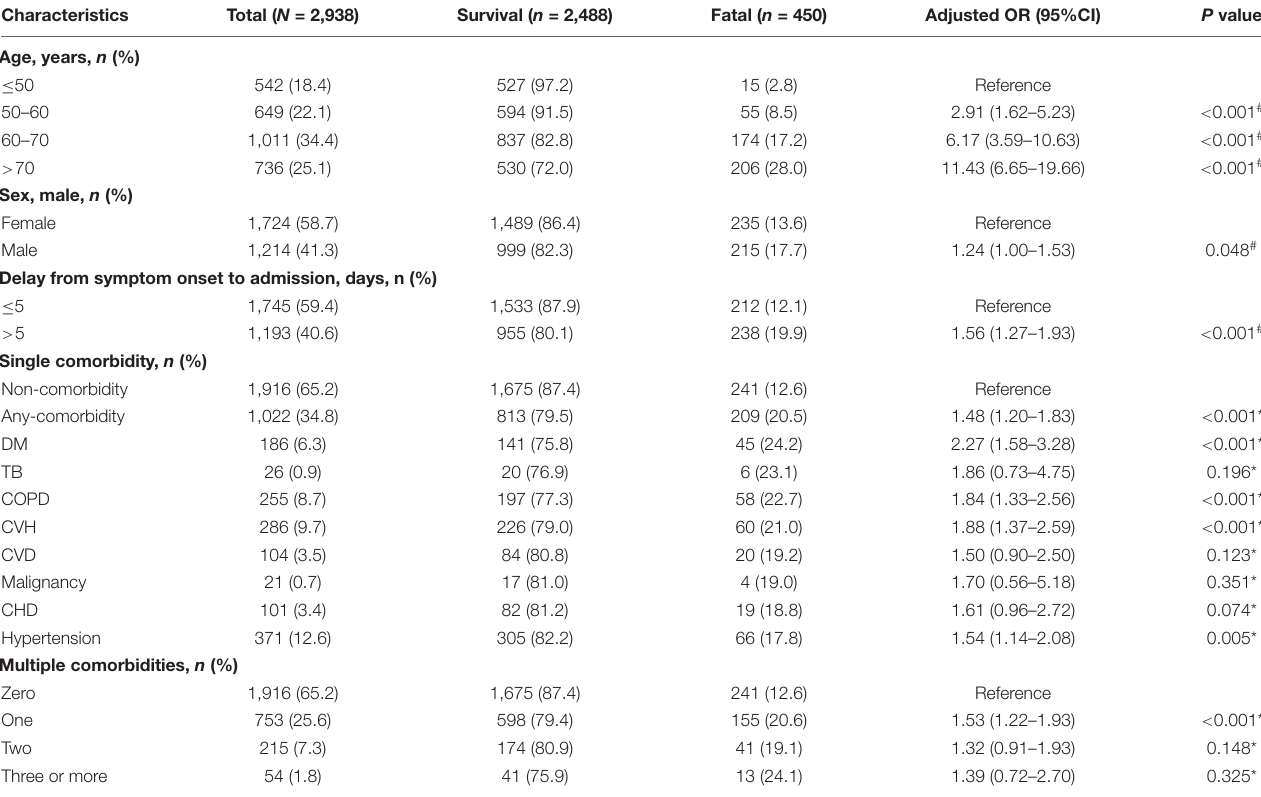
TABLE 1 | The risk of age, sex, delay from symptom onset to hospital admission and comorbidity for fatal outcome in SFTS